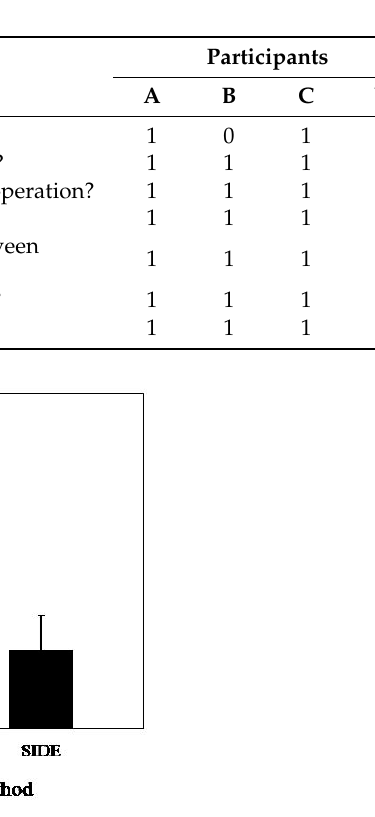
Table 8. Example of the evaluation of the proposed checklist (Pattern 1). “0” means “No”, “1” means “Yes”.)